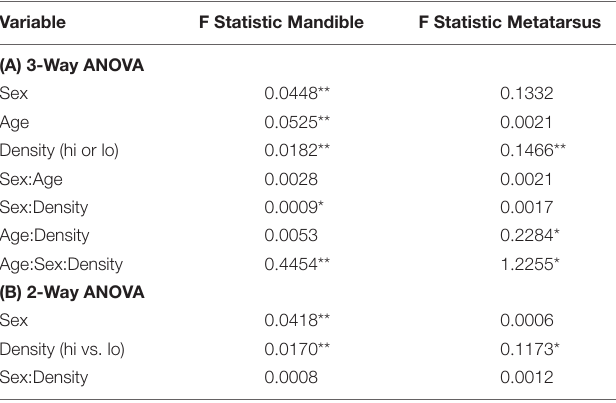
TABLE 4 | Bootstrapped ANOVA Results for various